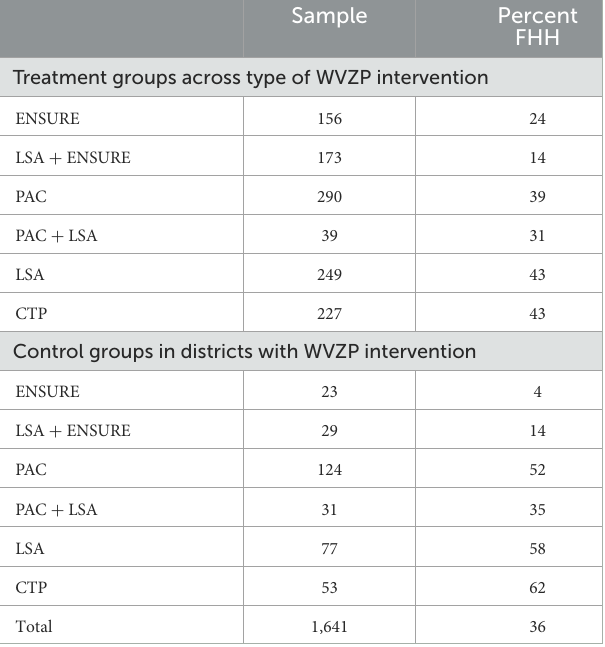
TABLE 2 Sample distribution across type of WVZP intervention and sex of household. Sample Percent